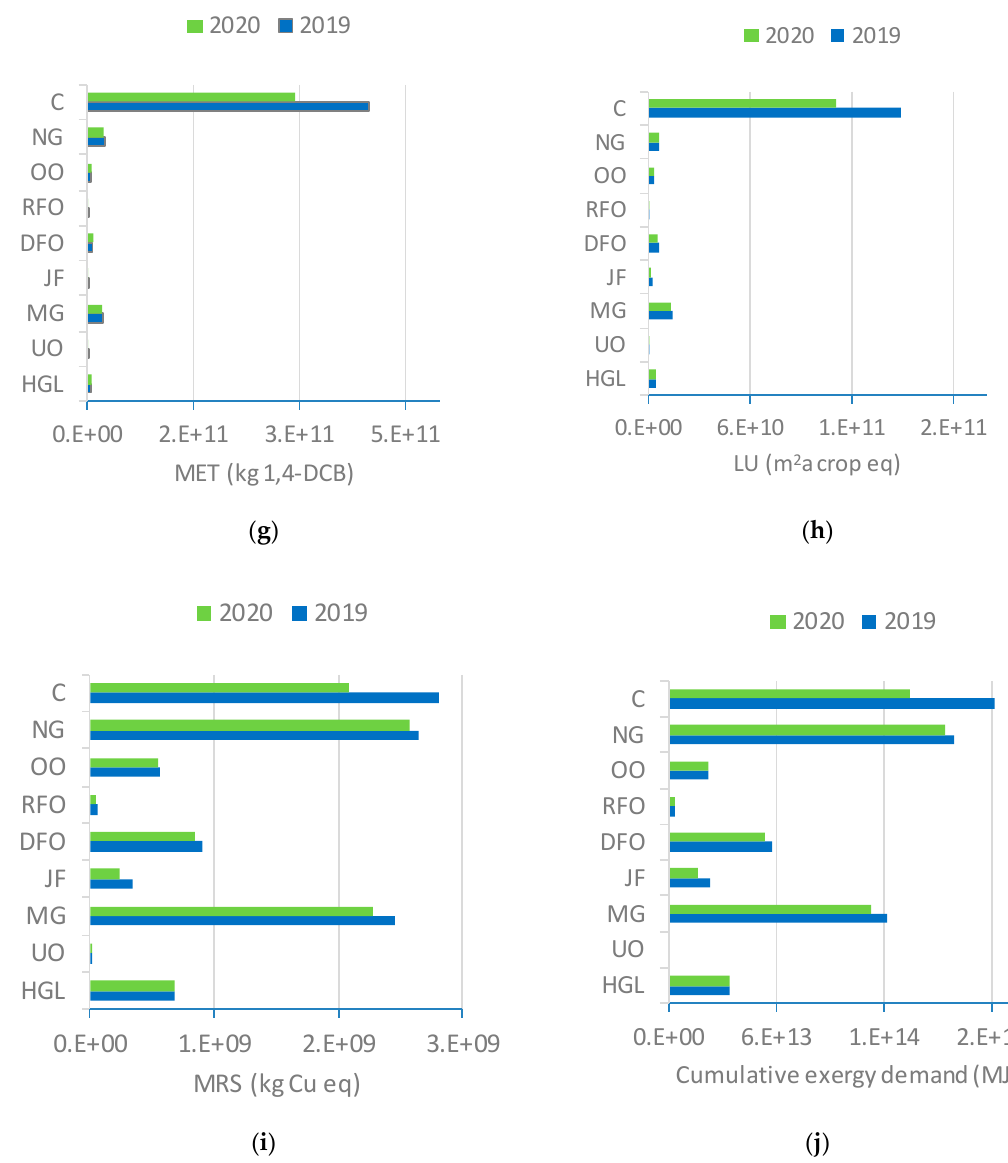
Figure 2. Changes in life cycle impacts due to reduced consumption of fossil fuels owing to the COVID-19 situation—( a ) ozone formation (terrestrial ecosystems) [OFTE], ( b ) terrestrial acidification [TA], ( c ) freshwater eutrophication [FE], ( d ) marine eutrophication [ME], ( e ) terrestrial ecotoxicity [TET], ( f ) freshwater ecotoxicity [FET], ( g ) marine ecotoxicity [MET], ( h ) land use [LU], ( i ) mineral resources scarcity [MRS], and ( j ) cumulative exergy demand.